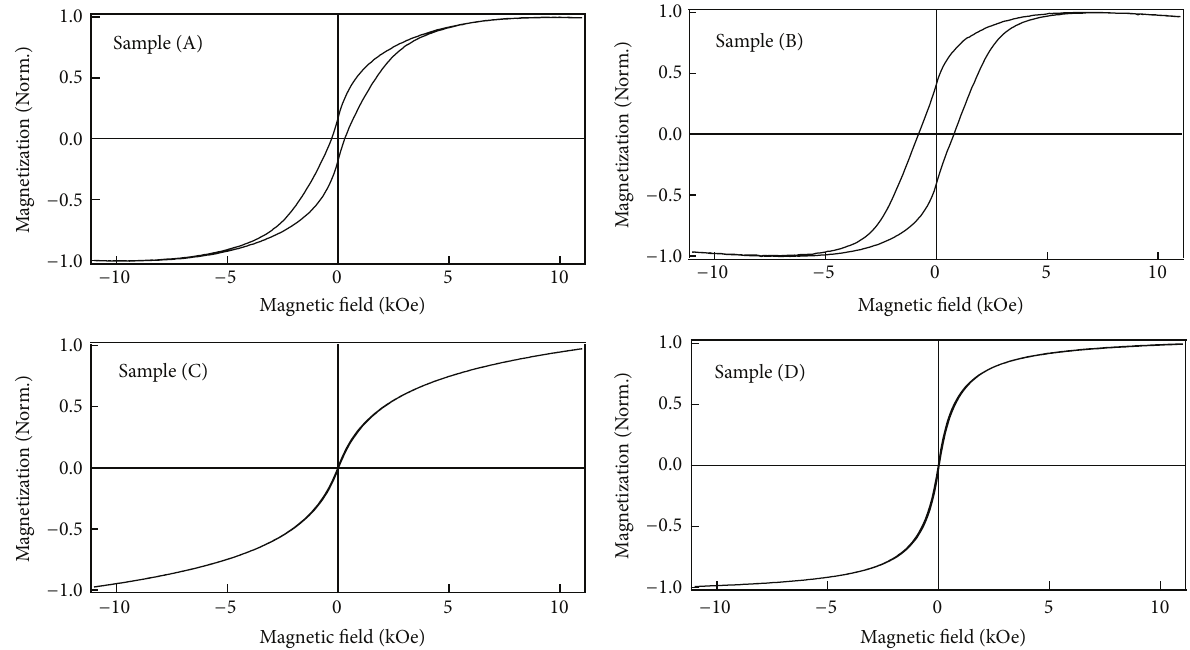
Figure 4: Hysteresis loop obtained for the samples: (A) without heat treatment, (B) calcined at 400 ∘ C, (C) calcined at 800 ∘ C, and (D) calcined at 1100 ∘